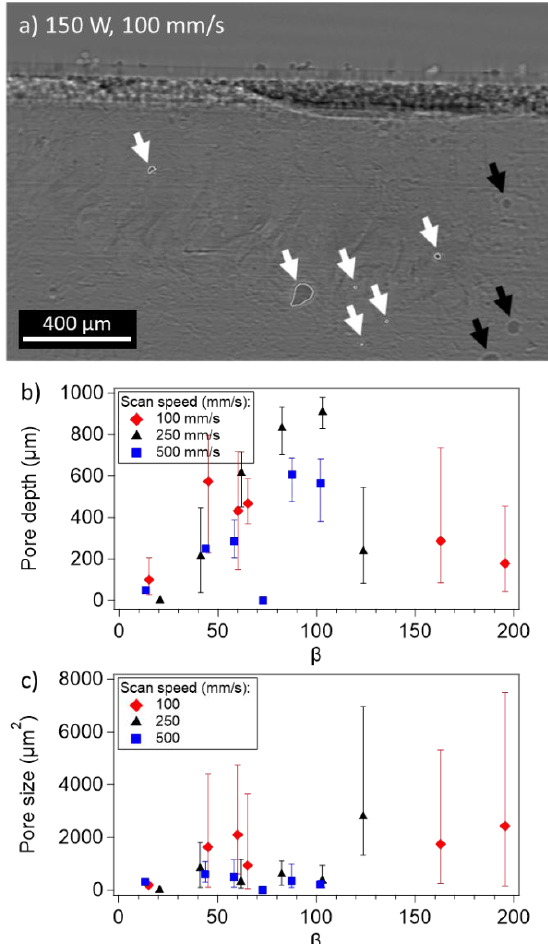
Figure 4. ( a ) Transmission X-ray image of WE43 showing pores formed during steady-state laser scanning (white arrows) and laser shut-off pores (black arrows to the right). The latter are not in- cluded in the pore count. ( b ) Average pore depth and ( c ) average cross-sectional pore size as a func- tion of normalized enthalpy, β . Error bars indicate the minimum and maximum values. The beam diameter is 50 µm for these experiments.